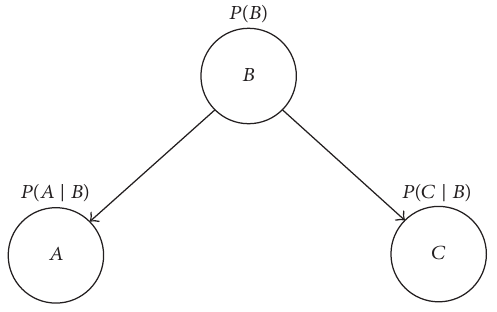
Figure 1: Example of Bayesian